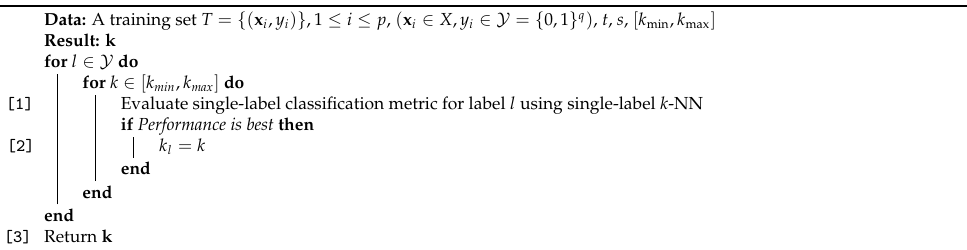
Algorithm 2: ML-k’sNN.SL: Multi-label k’s nearest neighbors algorithm single- label